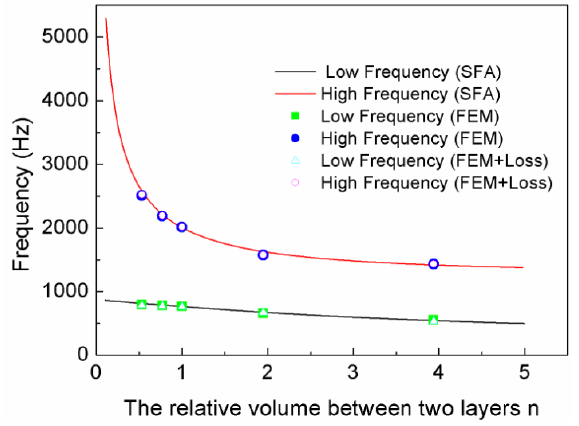
Figure 9. The relationship curves of the relative volume and resonant frequencies.